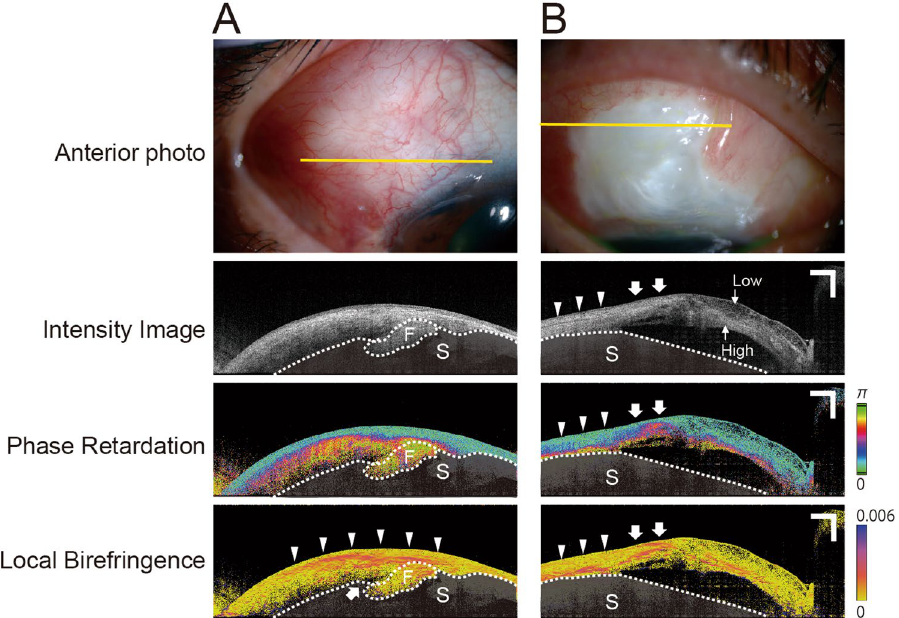
Figure 2. Representative cases show the sites of fibrotic tissue on local birefringence images. ( A ) A 57-year-old woman with a collapsed flat bleb, 4 months after trabeculectomy, had intraocular pressure (IOP) of 8 mmHg with hypotensive medications. Conjunctiva is not completely highly birefringent (arrowheads: covered by fibrotic tissue, arrows: open areas). ( B ) A 60-year-old man, 4 months after trabeculectomy, had IOP of 12 mmHg with hypotensive medications. The intensity image shows a low-reflectivity area (Low) and a high-reflectivity area (High), which are clearly separated from each other. The local birefringence image of the high-reflectivity area contains fibrotic tissue. The left area of the bleb shows high birefringence at the border of the conjunctiva and sclera (arrowheads), whereas the right area shows high birefringence in the middle of the conjunctiva (arrows). Sclera is covered with a semitransparent black shadow. The white dotted line delineates the boundary between the conjunctiva and sclera (S). Scale Bars, 1